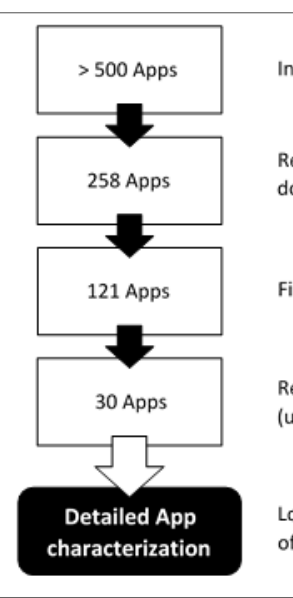
Table 2. Resulting apps possessing available published